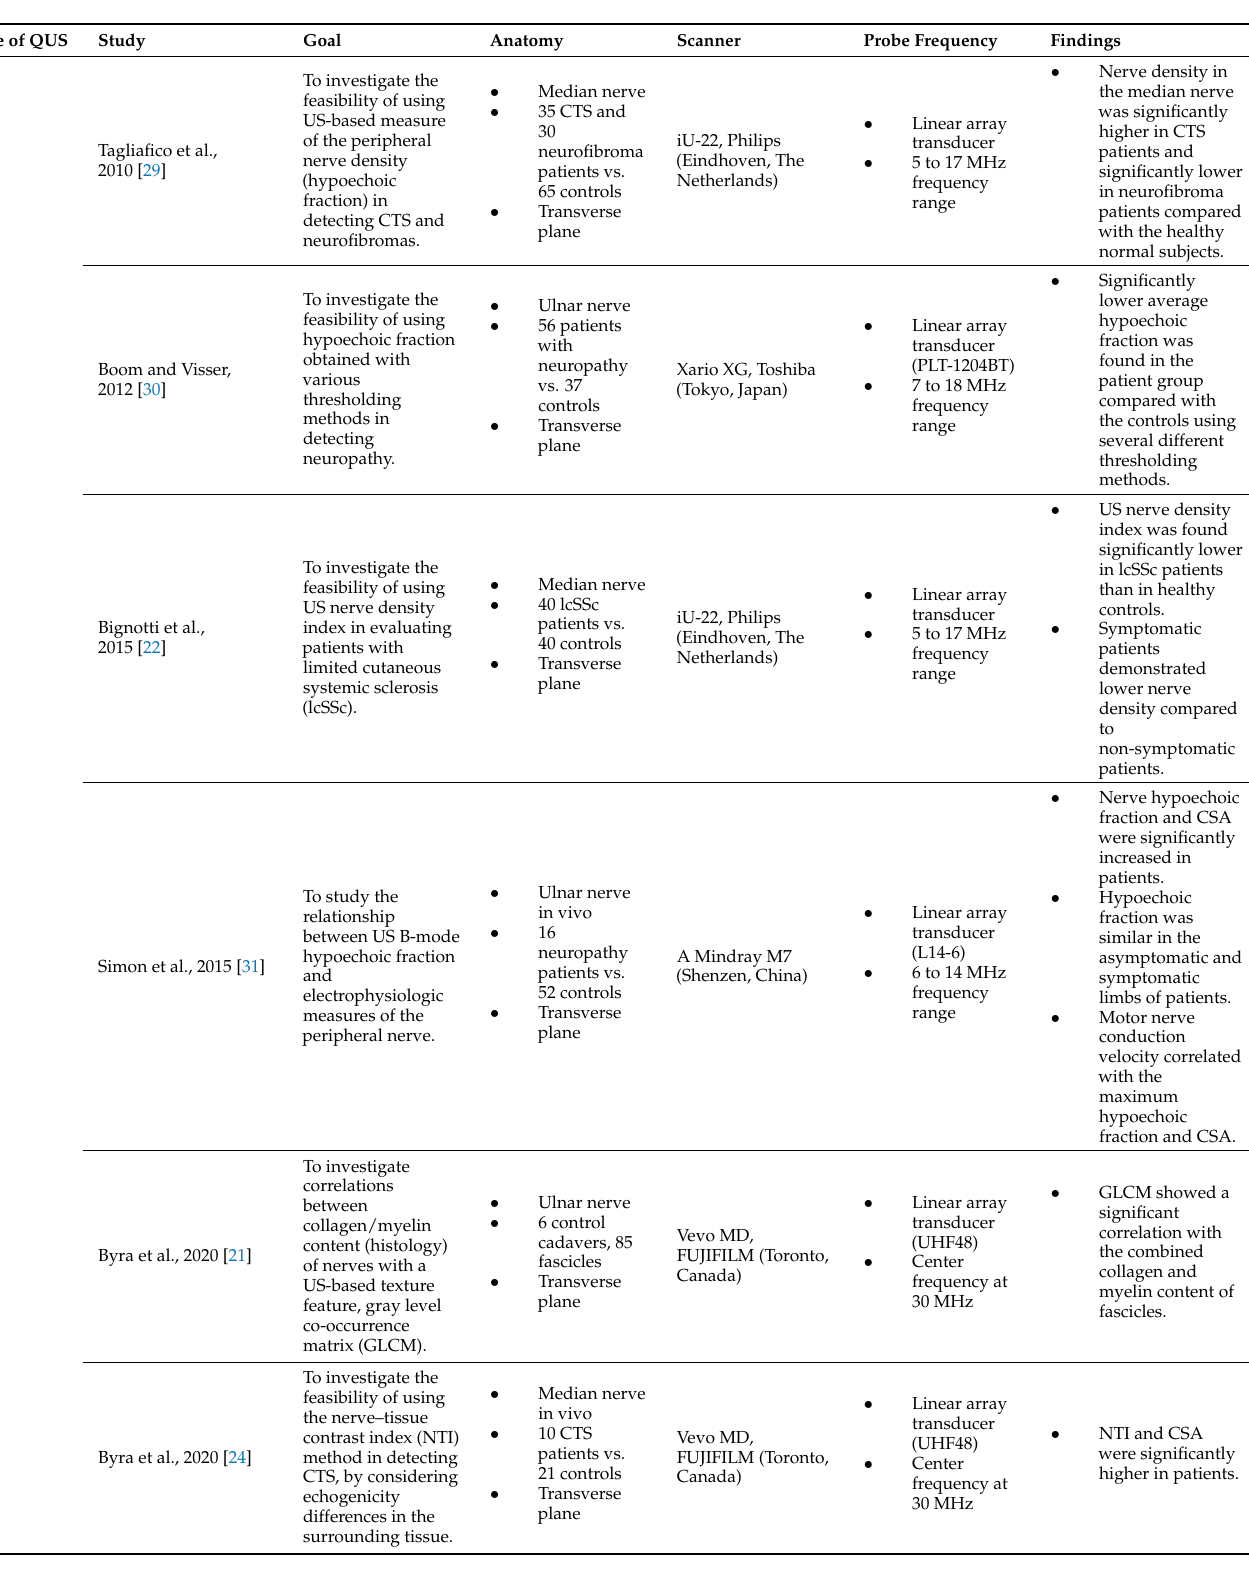
Table 1. QUS-based investigations performed on peripheral